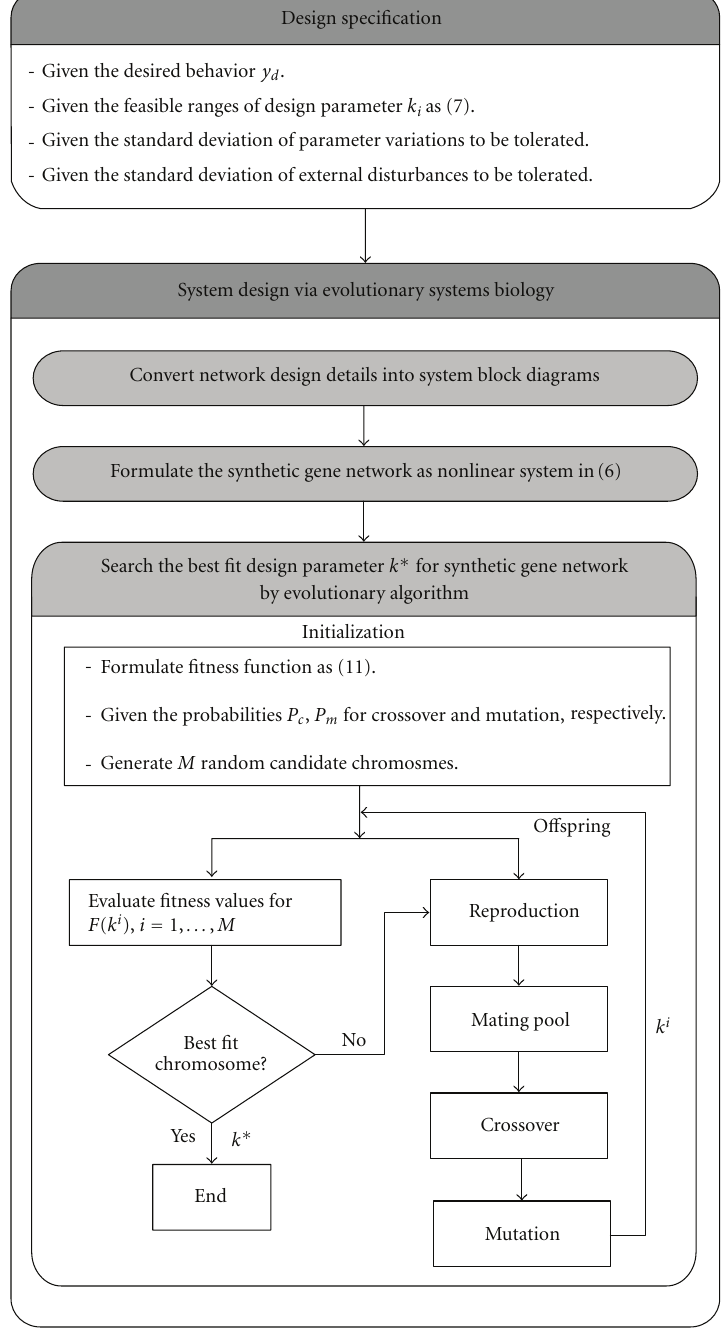
Figure 3: The flowchart of evolutionary systems biology algorithm for solving the best fit k ∗ from the maximization problem of fitness function in